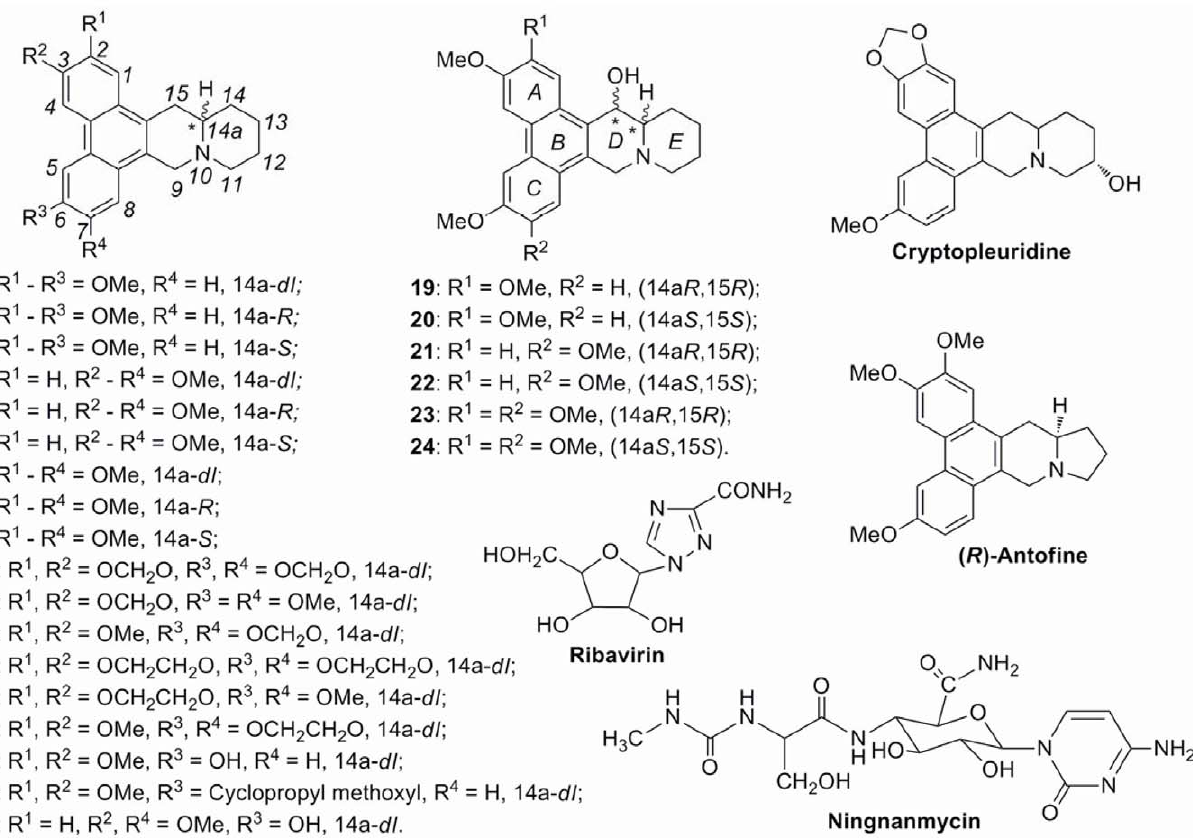
Figure 1. Chemical structures of compounds 1–24, Ribavirin, Ningnanmycin, Cryptopleuridine and ( R )-Antofine.